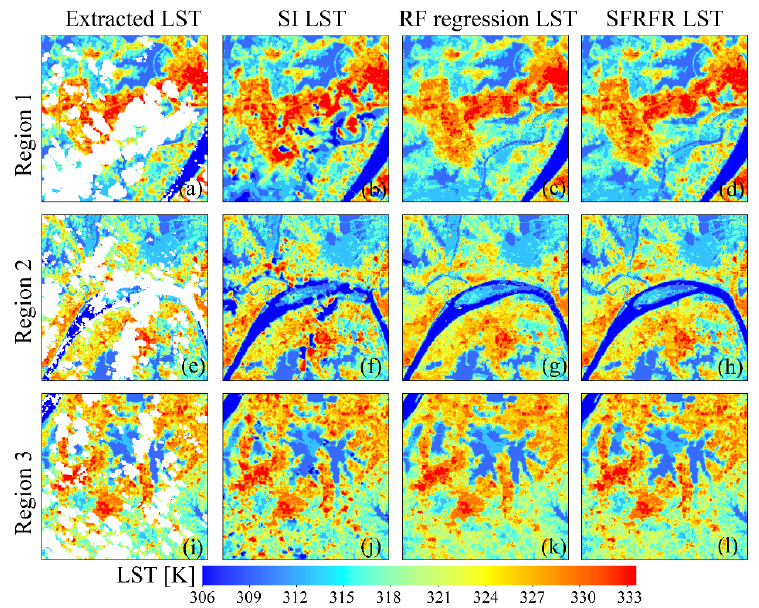
Figure 6. Visual performances of the reconstructed LST generated by the three models and the ex- tracted LST in regions 1, 2, and 3: ( a ) extracted LST in region 1, ( b ) SI LST in region 1, ( c ) RF regres- sion LST in region 1, ( d ) SFRFR LST in region 1, ( e ) extracted LST in region 2, ( f ) SI LST in region 2, ( g ) RF regression LST in region 2, ( h ) SFRFR LST in region 2, ( i ) extracted LST in region 3, ( j ) SI- LST in region 3, ( k ) RF regression LST in region 3, and ( l ) SFRFR LST in region 3.